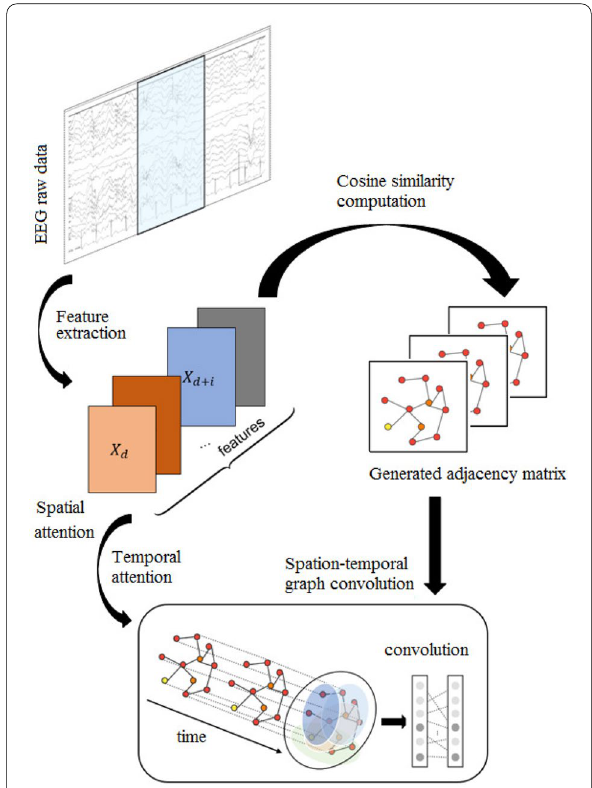
Fig. 2 The overall structure of the proposed model consists of three parts: the feature extraction and the mutual information computation part, the spatial–temporal attention mechanism part and spatial– temporal graph convolution